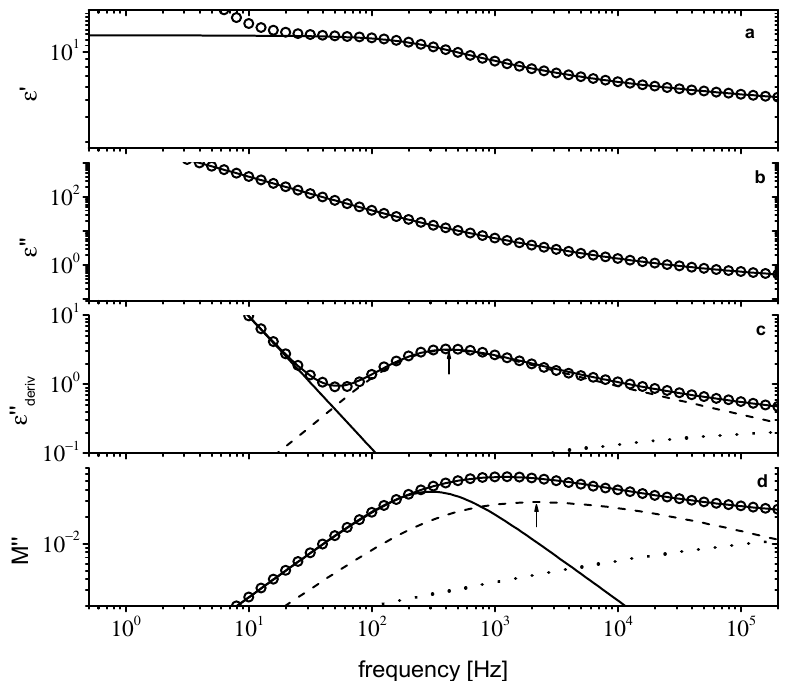
Figure 7. Dielectric data for [P 8881 ]Lev at 218 K. ε′(f) in ( a ), ε″(f) in ( b ), ε″ deriv (f) in ( c ), and M″(f) in ( d ). Solid lines are fitting curves. In ( c , d ), individual relaxations are shown as dashed and dotted lines. The solid line in ( d ) is conductivity relaxation (see text for details). The arrows in ( c , d ) indicate the main peak position.